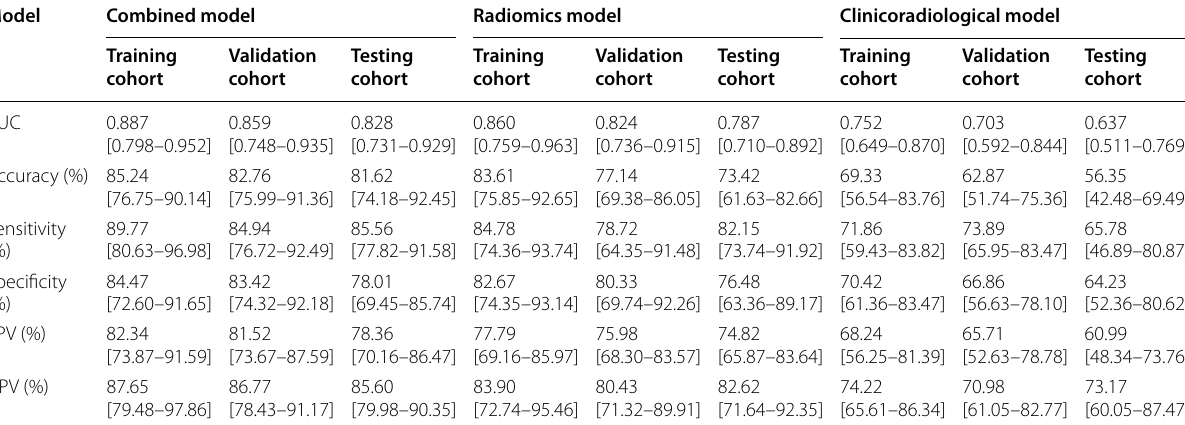
Data in parentheses are 95% CIs